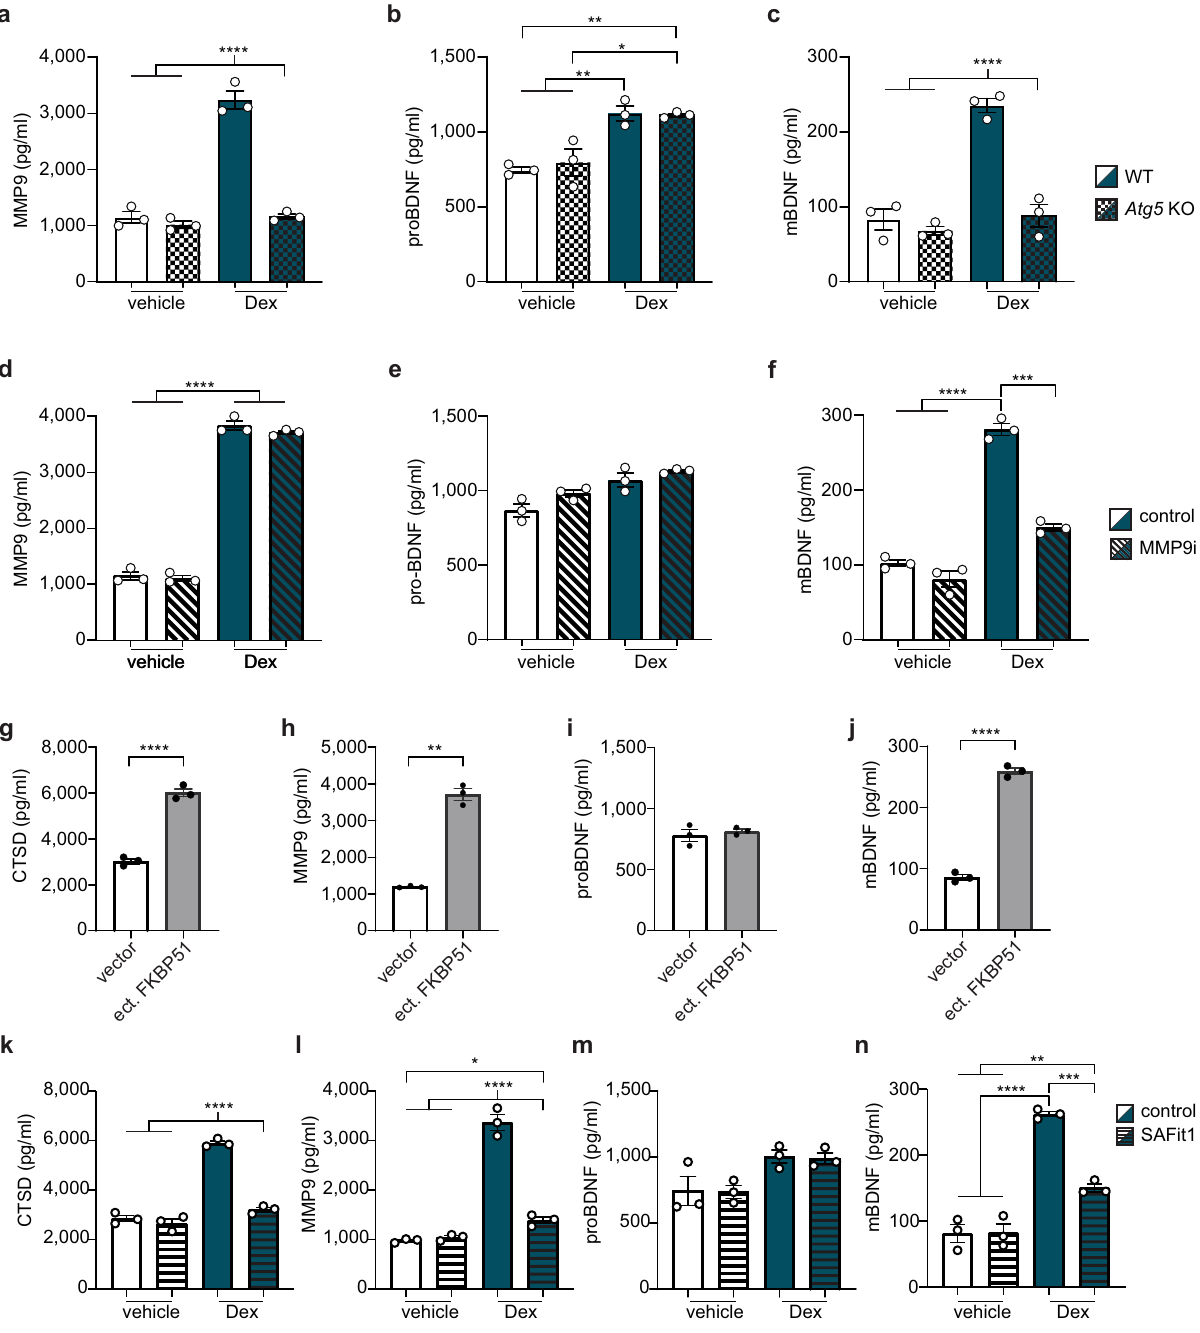
Fig. 4 Stress enhances mBDNF production promoting proBDNF cleavage via MMP9. a MMP9, b proBDNF, c mBDNF levels from supernatants